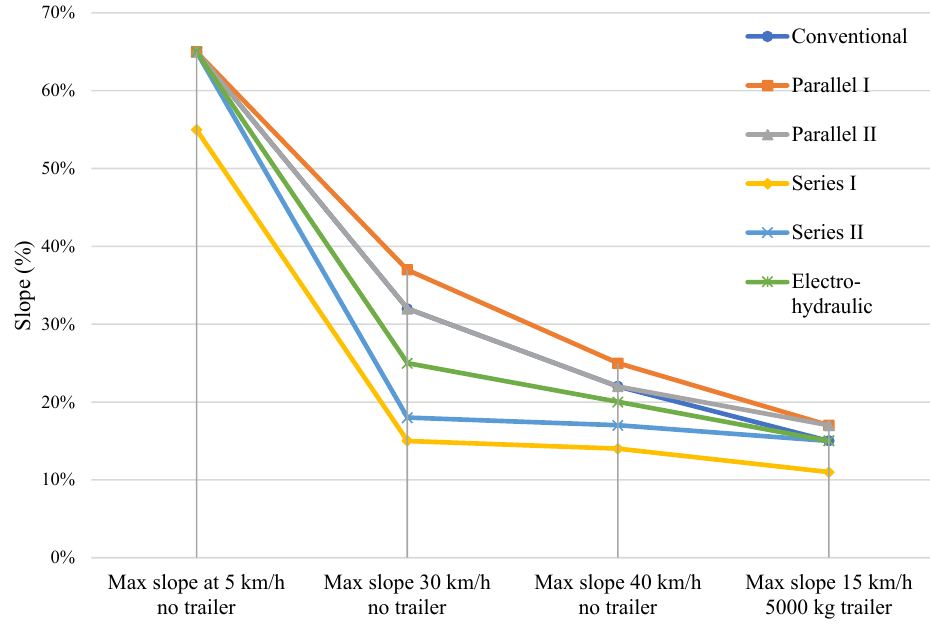
Figure 16. Comparison between the architectures’ slope